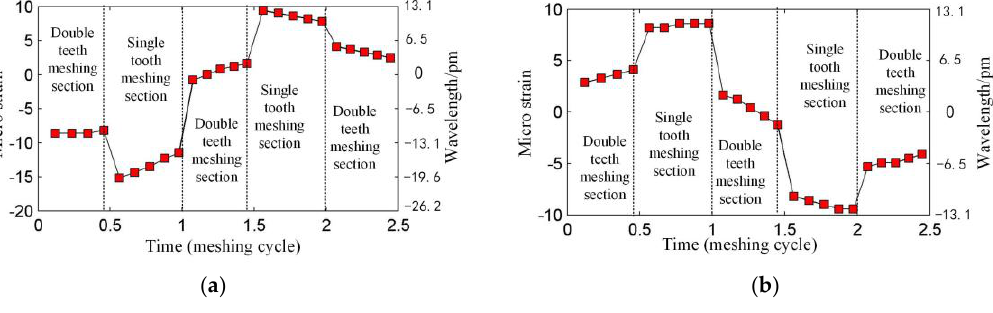
Figure 8. Strains measured by ( a ) FBG1 and ( b ) FBG2.